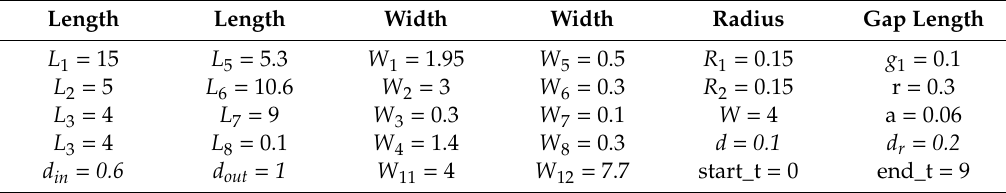
Table 3. Optimized structural parameters of the proposed filter (the units of length are mm, the units of angle are radian).